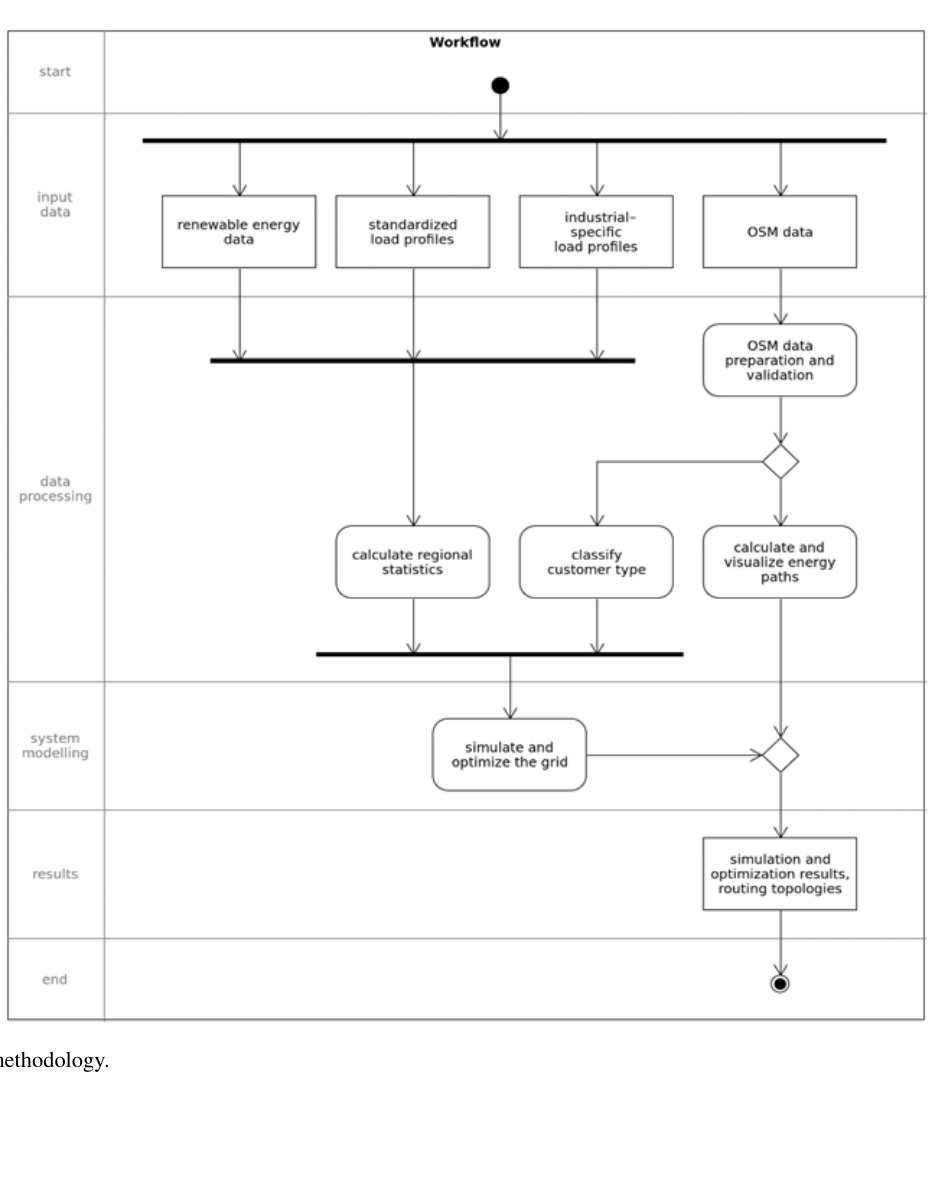
Figure 1. S6ET methodology.